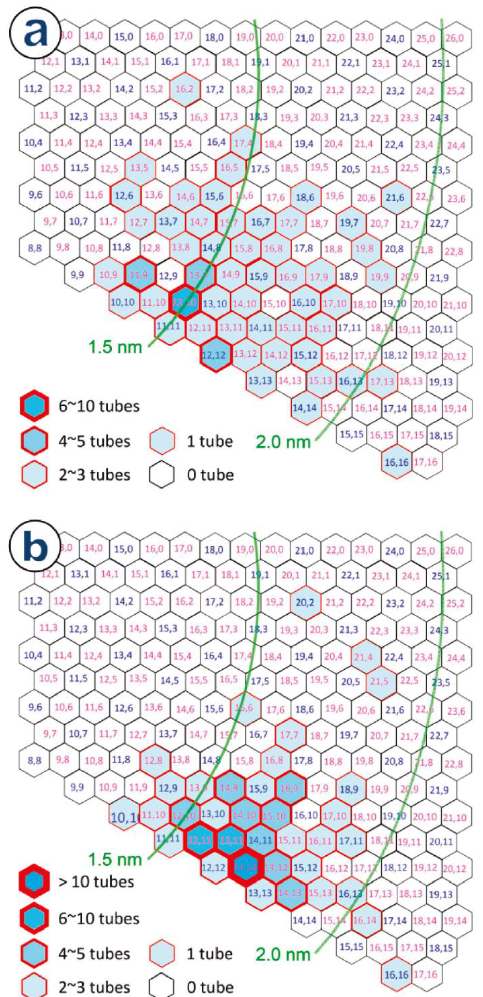
Figure 9. Chirality map distribution of samples produced using an aerosol floating-catalyst CVD process with ( a ) 0 ppm NH 3 and ( b ) 500 ppm NH 3 [49]. Copyright 2011, American Chemical